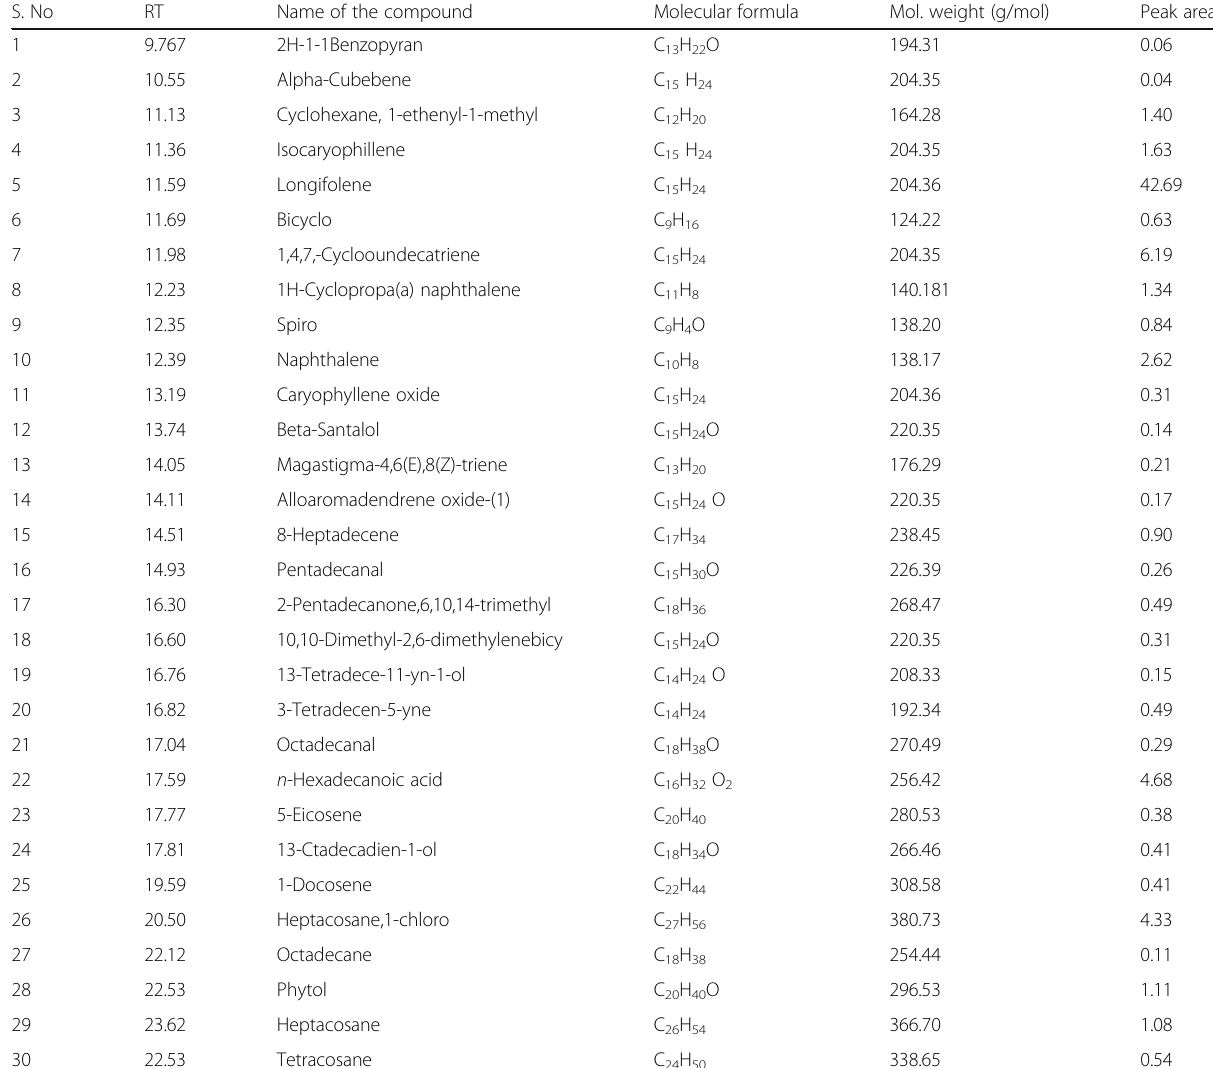
Table 2 Gas chromatography mass spectrometry of essential oil from the leaves of L . aspera S. No RT Name of the compound Molecular formula Mol. weight